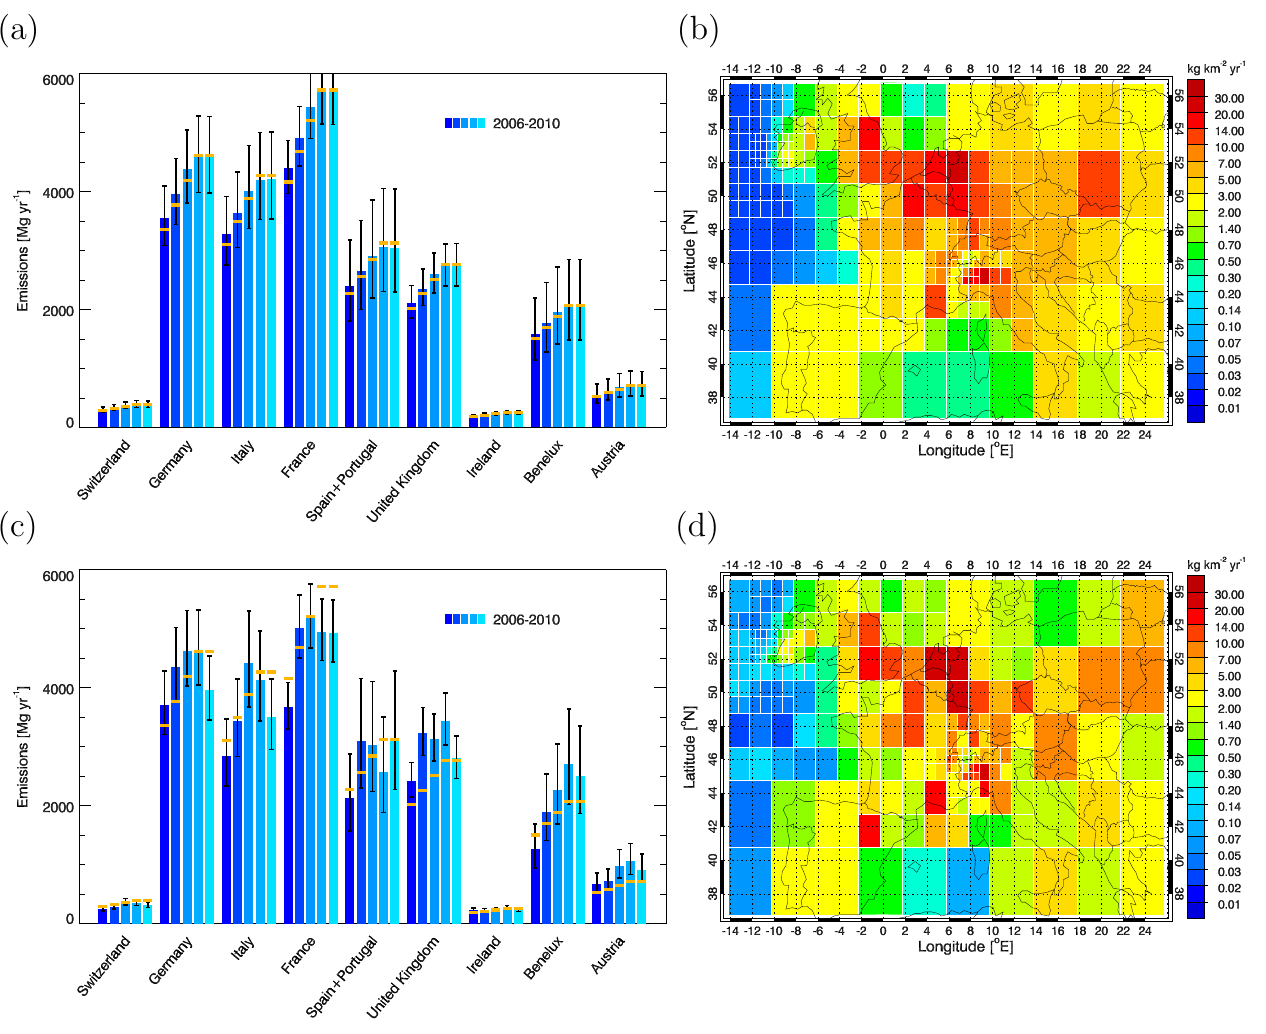
Fig. 7. Emission inversion results for noise-free Case 3 (upper panels (a) and (b) ) and noisy Case 7b (lower panels (c) and (d) ). Panels (a) and (c) represent annual mean emissions (2006–2010) estimated for selected countries. Blue bars are country-mean a posteriori emissions estimated by the Kalman filter together with their 1 σ uncertainties. True reference emissions are overlaid as orange horizontal bars. Panels (b) and (d) are annual mean emission maps for the year 2010.